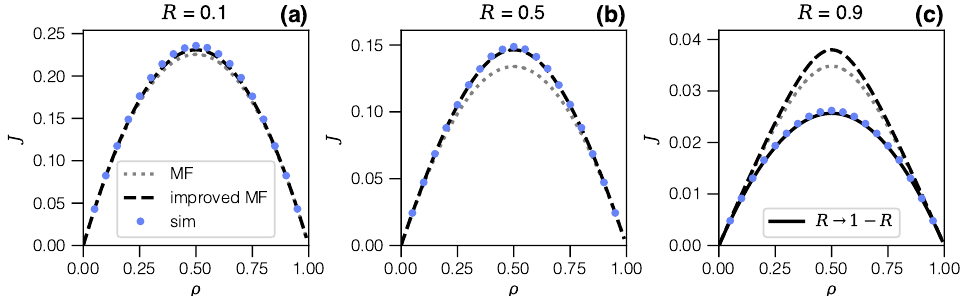
Figure 6: Plots of the current J = γ − ρ + as in Fig. 3, displaying the three regimes separately. The dotted gray curve represents the mean-field (MF) solution with ρ + as found in Eq.(8), the black dashed curve is the solution of the improved mean-field from Eq.(13) and the full black curve in panel (c) is Eq. (13) after exchanging